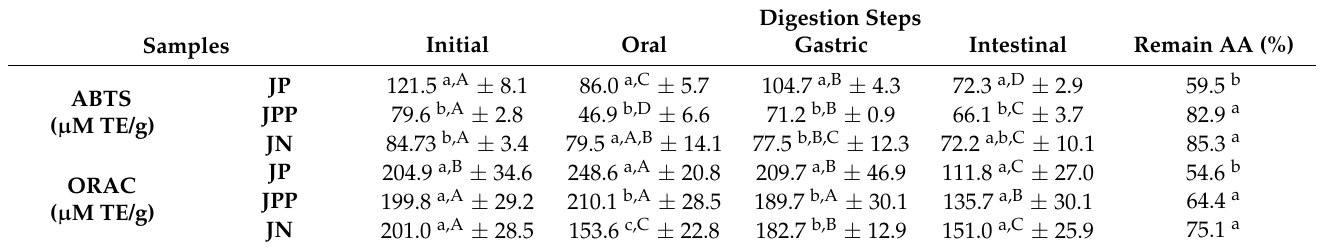
Table 2. Determination of antioxidant activity (AA) during the simulated digestion process (in